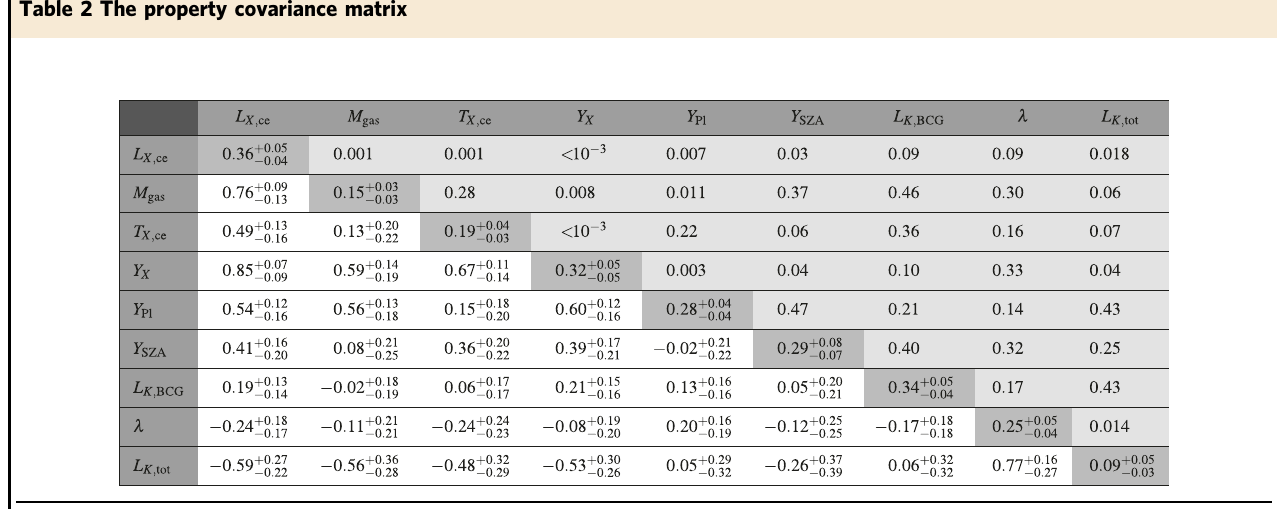
Table 2 The property covariance matrix